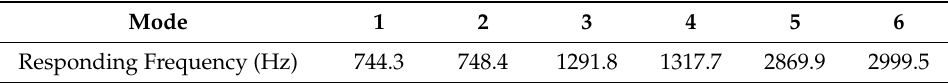
Table 3. The first six natural frequencies of the sensor.